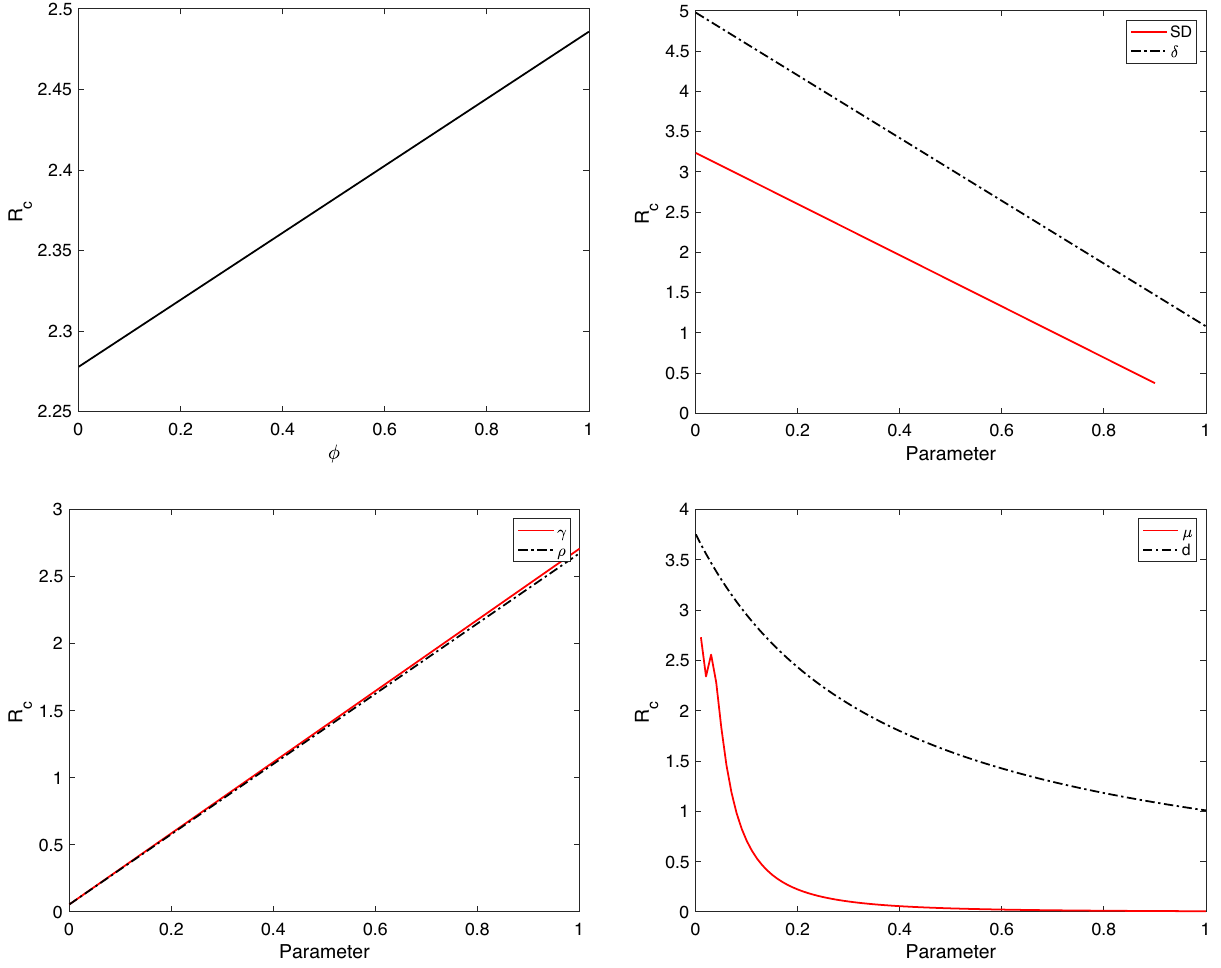
Figure 10. The sensitivity of R c of system (7) with respect to the parameters φ , SD , ρ , δ , γ , d , and µ .